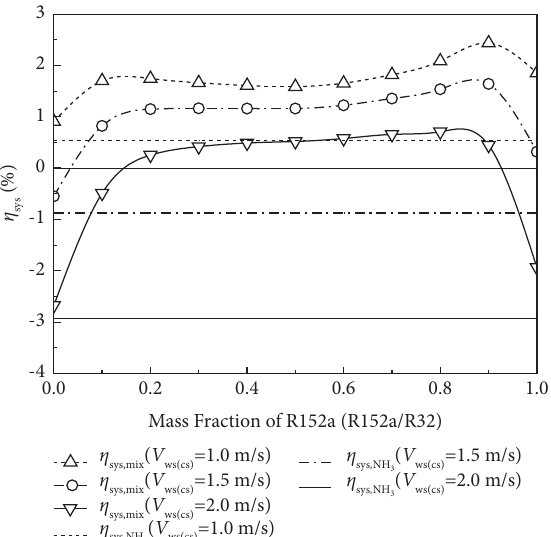
Figure 8: System efciency of R152a/R32 and NH 3 under diferent seawater velocities in the pipeline.